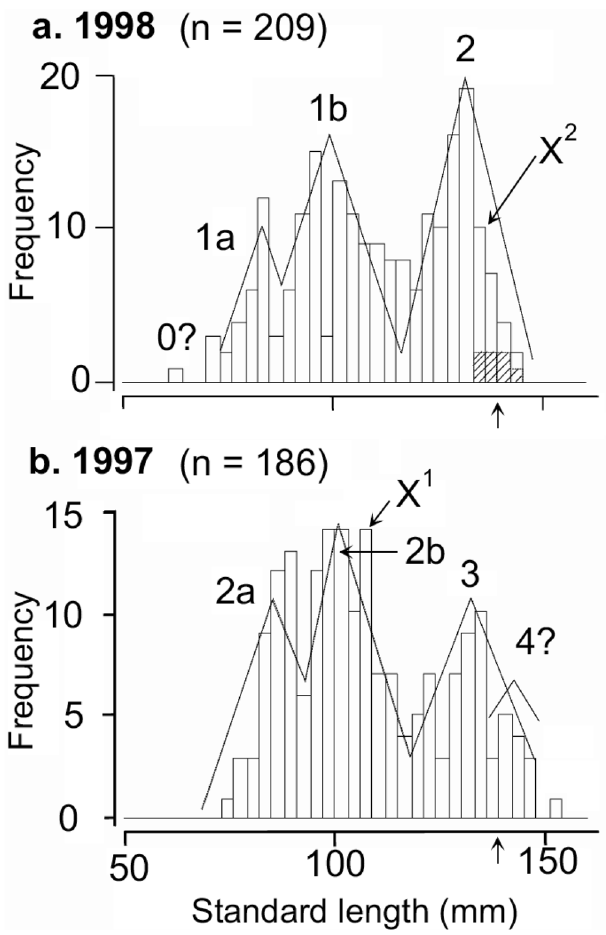
Fig. 9. Frequency distribution of the size of Symphysodon haraldi from a single large colony in Uxi Bay, lago Amanã. Column bin-intervals are 3 mm. See Fig. 2 for the timing of sampling in (a) 1998 and (b) 1997. Specimens parasitized with Braga cichlae are excluded. Major modes in the multi-modal distribution of SL are marked with dotted lines and labeled as putative cohort groups (0, 1a, 1b, 2a, 2b, 3, 4) (refer to Fig. 2). Arrows on the x-axis mark the maximum known size of females. X refers to a male specimen marked and released on 20 December 1997 (X 1 ), and recaptured (X 2 ) on 16 November 1998. The overlapping shaded histogram for the 1998 data refers to seven discus captured in adjacent shore scrub. The histograms distributions marked by the beginnings and ends of the dotted triangles for 1a, 1b, and 2 in 1998, and 2a, 2b and 3 in 1997 fit normal distributions (p < 0.01, one sample Kolmogorov-Smirnov